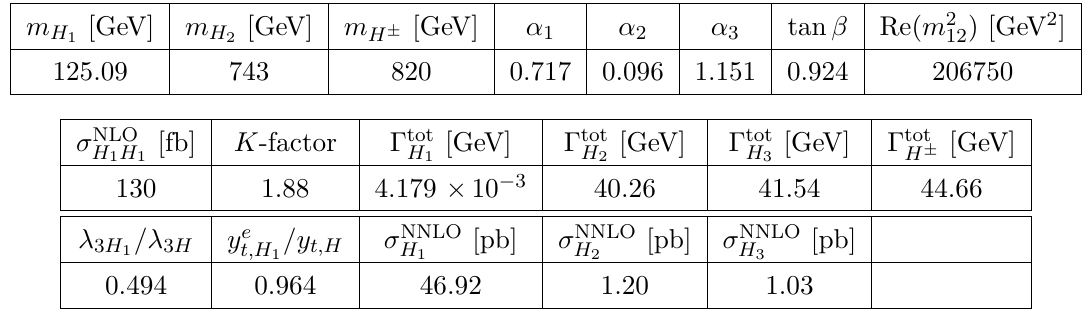
Table 12 . BP5 Upper: C2HDM-II input parameters. The third Higgs boson mass calculated from the input parameters is given by m = 753 GeV. Lower: additional double and single Higgs H 3 production related information. The value for y e is the CP-even part of the Yukawa coupling. t,H 1 The CP-odd part for the SM-like Higgs is very